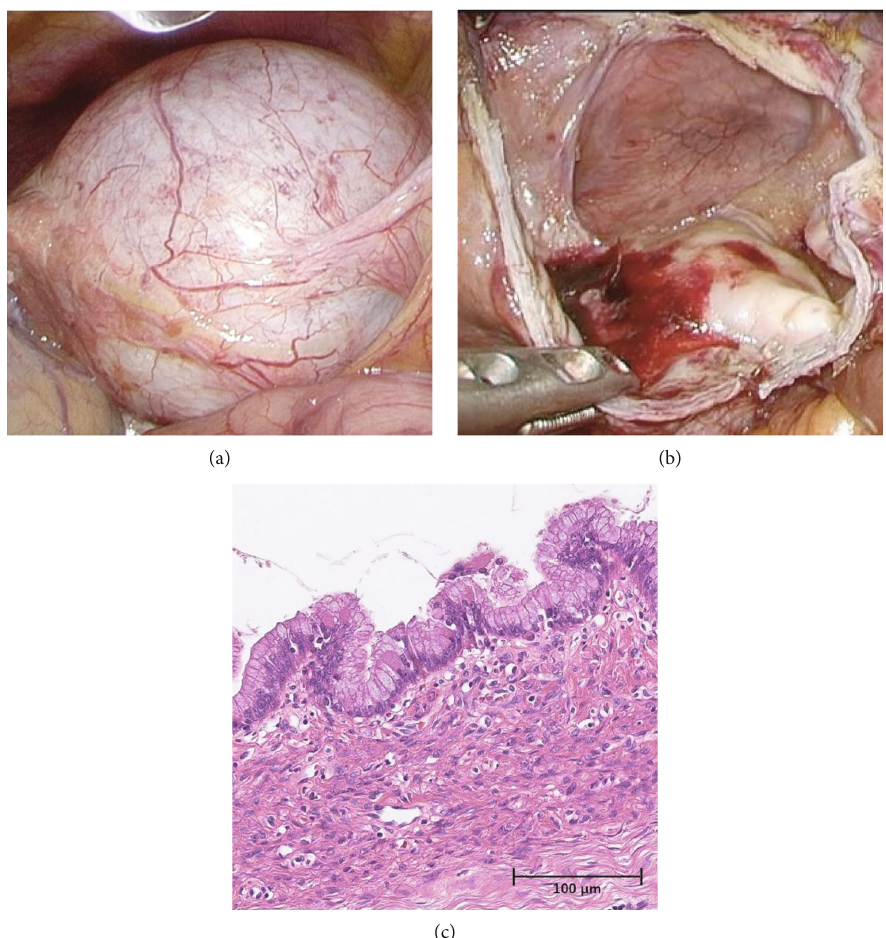
Figure 2: Intraoperative view before deroo fi ng (a). A unilocular white cystic tumor was observed in the medial segment of the liver. Intraoperative view after deroo fi ng (b). The lumen of cystic lesions was like velvet. Histopathological fi ndings (hematoxylin and eosin staining, × 200 magni fi cation) (c). The cyst wall was lined by mucin-producing atypical epithelium, which was surrounded by ovarian- like stroma. These fi ndings indicated MCN-L.